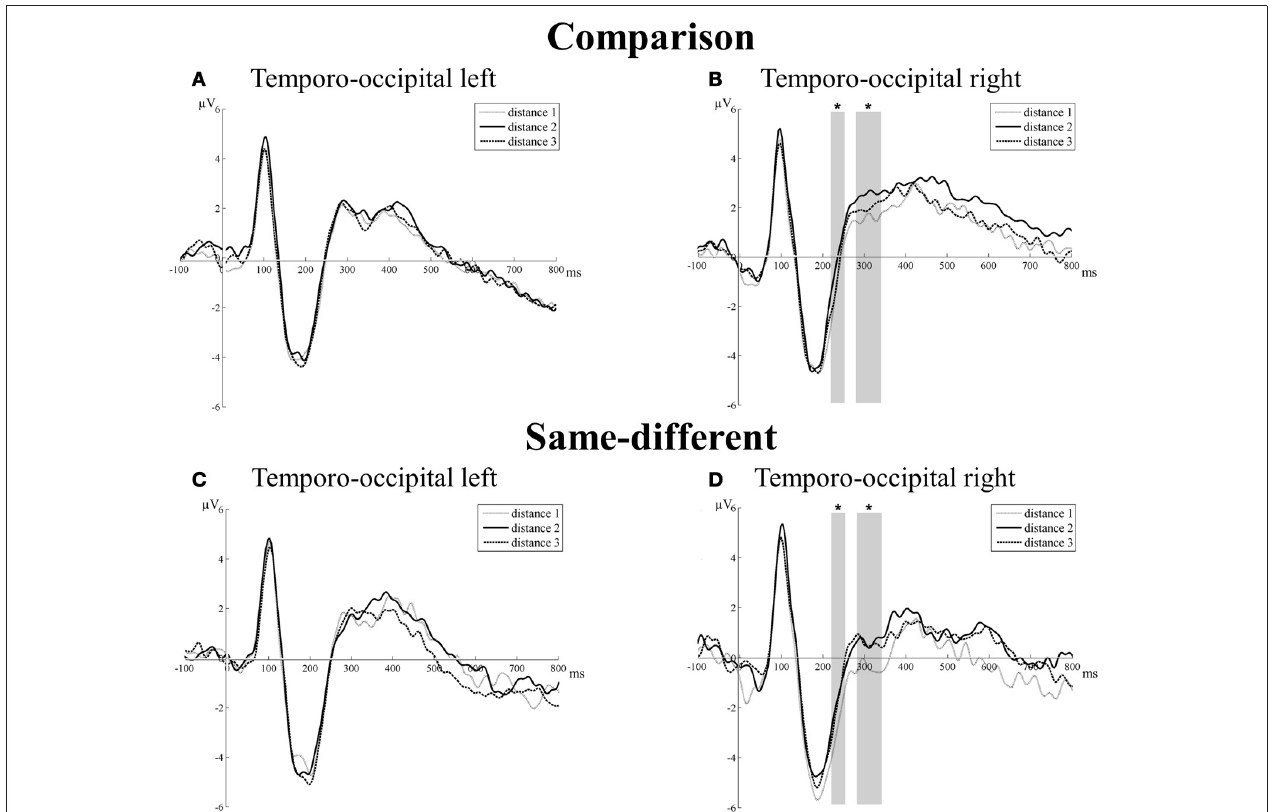
FIGURE 3 | Neural results for the temporo-occipital electrode group of the comparison (A and B) and the same-different task (C and D) for the left and right hemisphere. Significant effects of distance are indicated with an asterisk. A distance effect was present in the comparison and